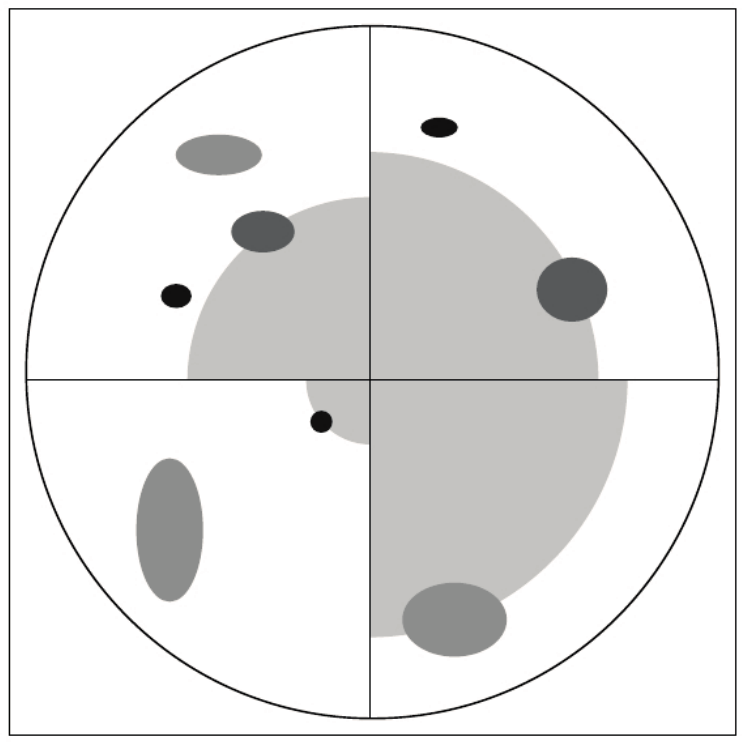
Figure 3. Illustration of the point-centred quarter sampling method (PCQ) applied at each sample plot. The shading of the tree crown ellipses reflects the respective tree height group (dark grey: <1 m, grey: 1–2 m, lighter grey: >2 m). The sampled tree closest to the plot centre defines the nontree area in each quadrant (light grey polygon in each